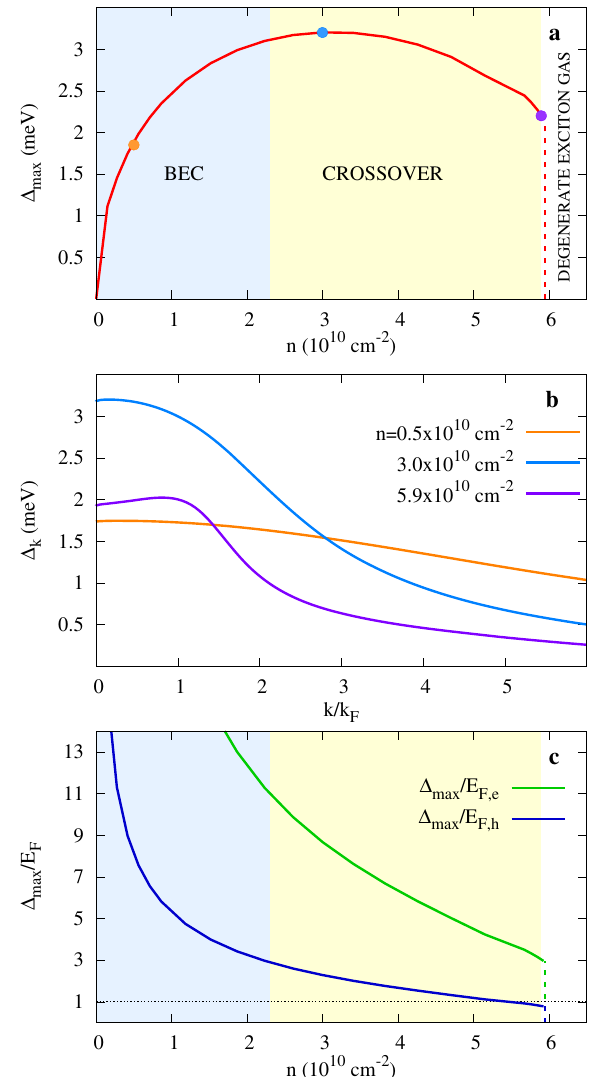
Fig. 2 Properties of the zero-temperature super fl uid gap. a Maximum of the gap Δ max as a function of the equal carrier densities n . The blue and yellow areas represent the BEC and BCS – BEC crossover regimes. The BCS regime is suppressed by screening. b Momentum dependent gap Δ k at the three densities n indicated by the colour-coded dots on the curve in ( a ). c Δ max scaled by the electron and hole Fermi energies E F,e and E F,h